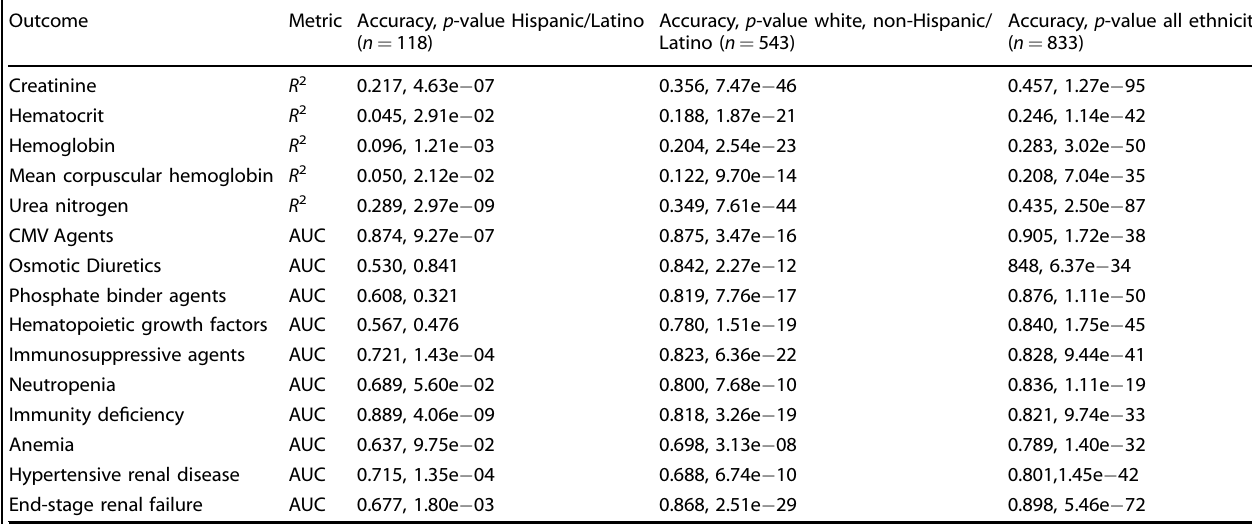
Table 1. Replication statistics within ethnic groupings.